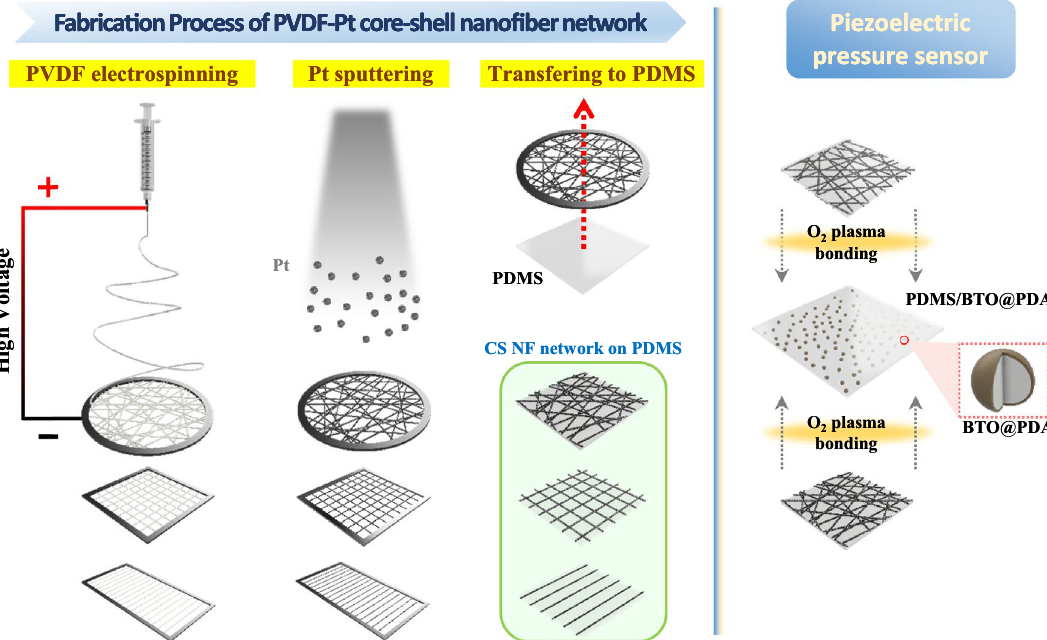
Figure 1. Schematic diagram of the fabrication processes of the CS NF networks, comprising PVDF electrospinning, Pt sputtering, and transferring to a PDMS substrate. The piezoelectric composite comprising a PDMS matrix and BTO@PDA nanoparticles is sandwiched by the top and bottom CS NF networks on PDMS substrates to fabricate a piezoelectric pressure